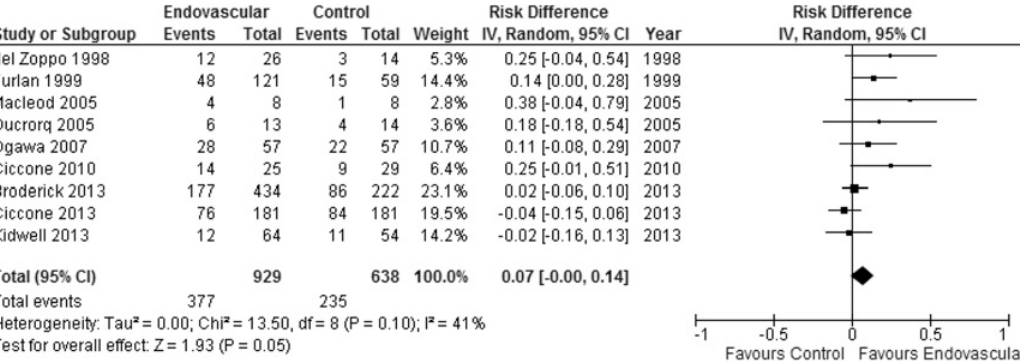
Fig 3. Modified Rankin Score 0 – 2 at 90 days expressed as absolute risk differences (ARD).